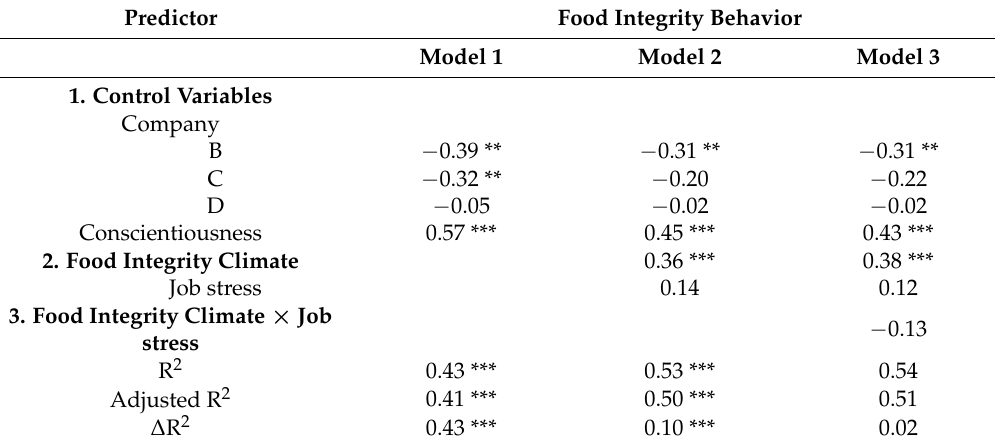
Table 4. Hierarchical linear regression of the moderator job stress ( n = 118 participants). Standardized regression coefficients for the respective regression steps are reported. Conscientiousness, food integrity climate and job stress are centered around the mean (** p < 0.01, *** p < 0.001; Company A is reference category). Hypothesis 2A was rejected, since job stress appeared not to have a moderating effect in the relation between food integrity climate and food integrity